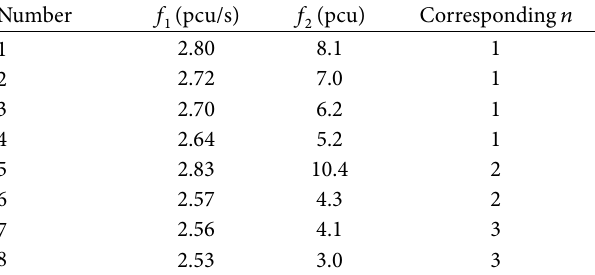
Figure 10: Pareto frontier when t Table 3: Pareto frontier of the morning peak period.